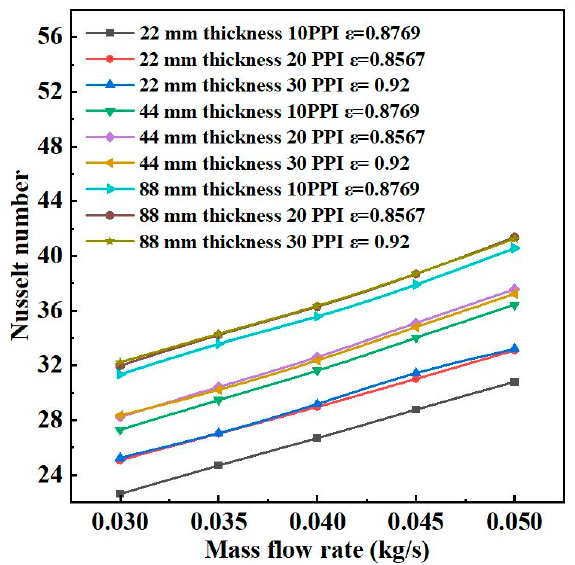
Figure 11. Variation of Nusselt number for different mass flow rates for different PPI and different thicknesses .